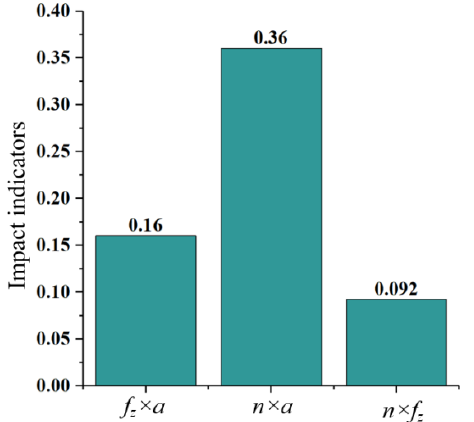
Figure 10. The influence index of machined surface positional error.